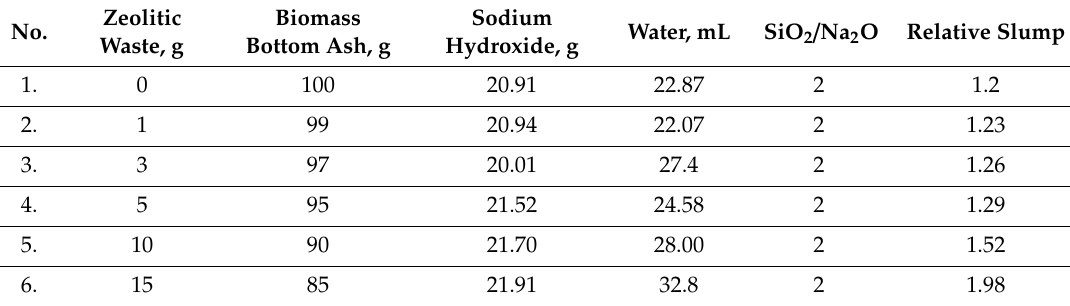
Table 2. Alkali-activated biomass bottom ash blends’ mixing